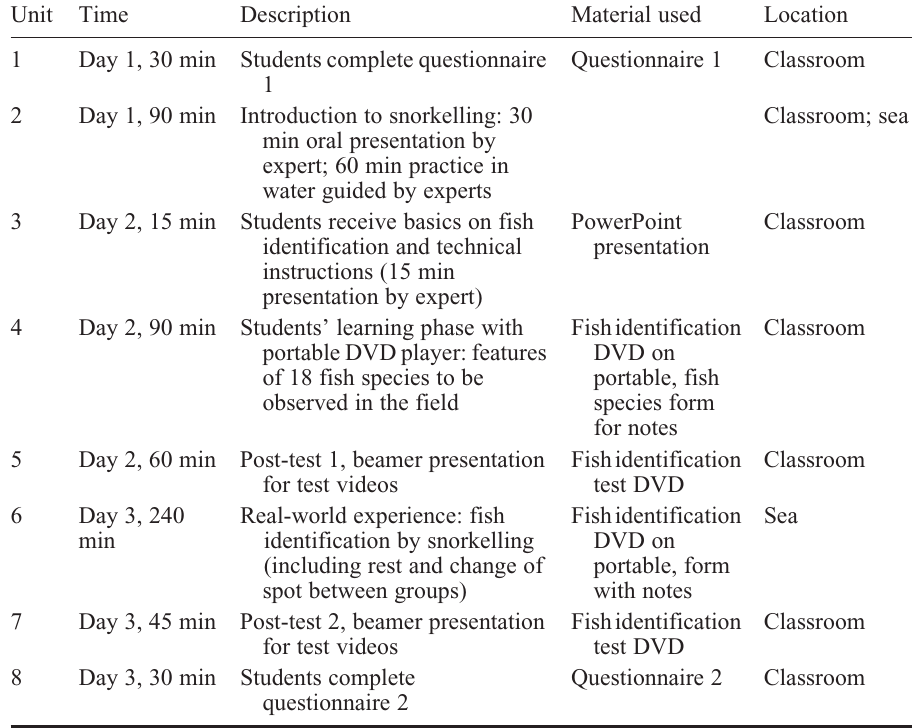
Table 1. Course of the 3-day study conducted at the Mediterranean coast of northern Spain, Costa Brava Unit Time Description Material used